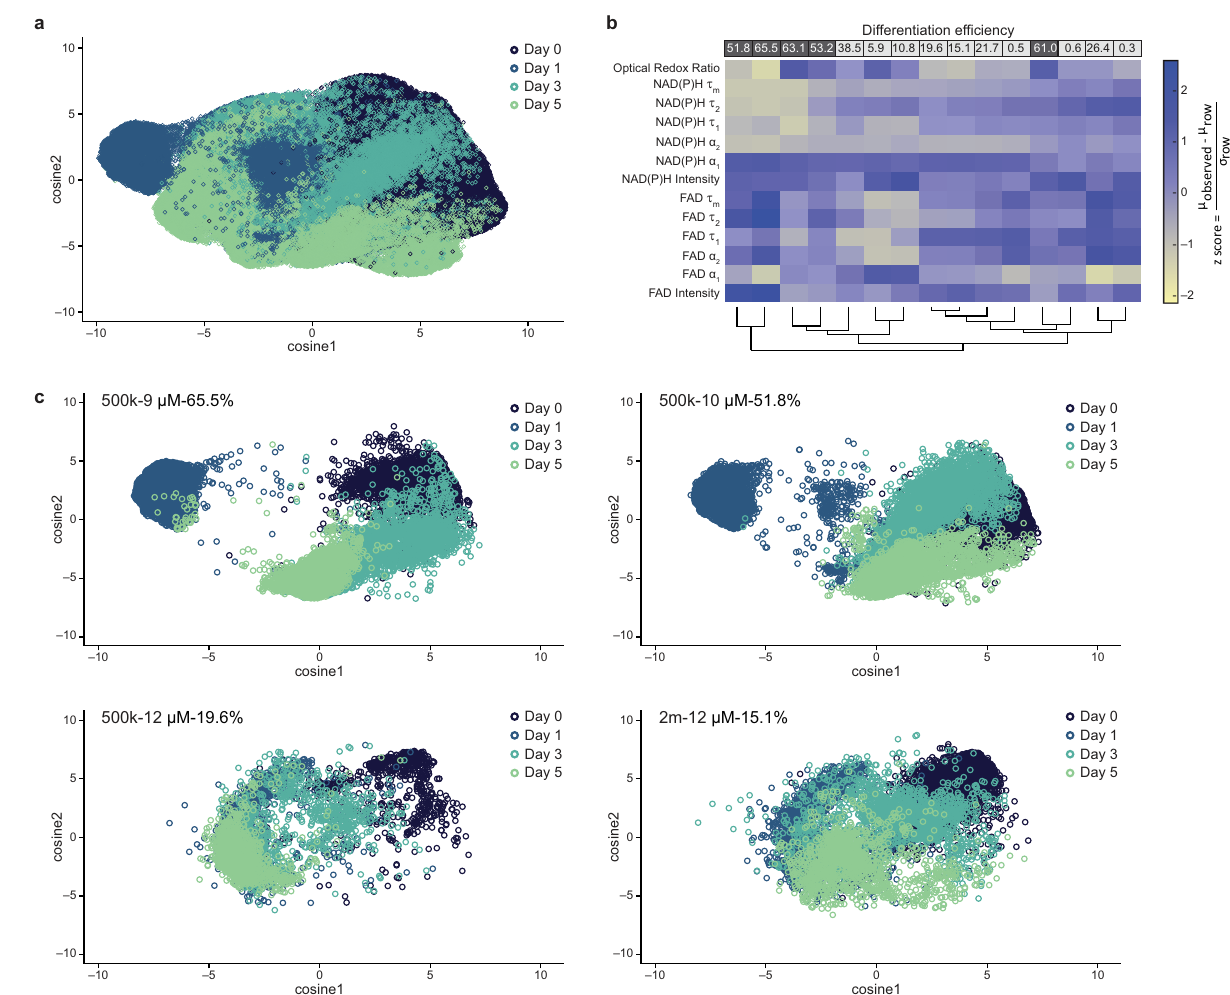
Fig. 2 Multivariate analysis reveals unique metabolic pro fi les in cells differentiated into cardiomyocytes at day 1. a Uniform Manifold Approximation and Projection (UMAP) dimensionality reduction was performed on all 13 auto fl uorescence variables (optical redox ratio, NAD(P)H τ m , τ 1 , τ 2 , α 1 , α 2 , and intensity; FAD τ m , τ 1 , τ 2 , α 1 , α 2 , and intensity) for each cell and projected onto 2D space. Cells from all 11 conditions shown in Table 1 are plotted together. Data include cells from day 0, day 1, day 3, and day 5. Each dot represents one single cell, and n = 25,304, 25,470, 26,228, and 23,484 cells for day 0, 1, 3, and 5, respectively. b Heatmap dendrogram clustering based on similarity of average Euclidean distances across all variable z-scores was performed on day 1 cells across all 15 conditions. Conditions are indicated by the CM differentiation ef fi ciency percentages as noted by column labels at the top of the heatmap (quanti fi ed by fl ow cytometry cTnT + on day 12, full conditions given in Table 1). Low differentiation ef fi ciencies (< 50%) are in italic and high differentiation ef fi ciencies are in bold ( ≥ 50%). Z-score = μ observed (cid:1) μ row σ , where μ observed is the mean value of each variable for each condition; μ row is the mean row value of each variable for all 15 conditions together, and σ row is the standard deviation of each variable across all 15 conditions. Auto fl uorescence variables are indicated on the left side as row labels. n = 30463 cells from day 1. c Separated UMAP clusters for representative differentiation conditions. Conditions are labeled with original cell seeding density, CHIR99021 treatment concentration, and fi nal cardiomyocyte differentiation ef fi ciency quanti fi ed by fl ow cytometry (detailed in Table 1). n = 13,897, 13,852, 4357, and 7601 cells for condition 65.5%, 51.8%, 19.6%, 15.1%, respectively. Source data are provided as a source data fi